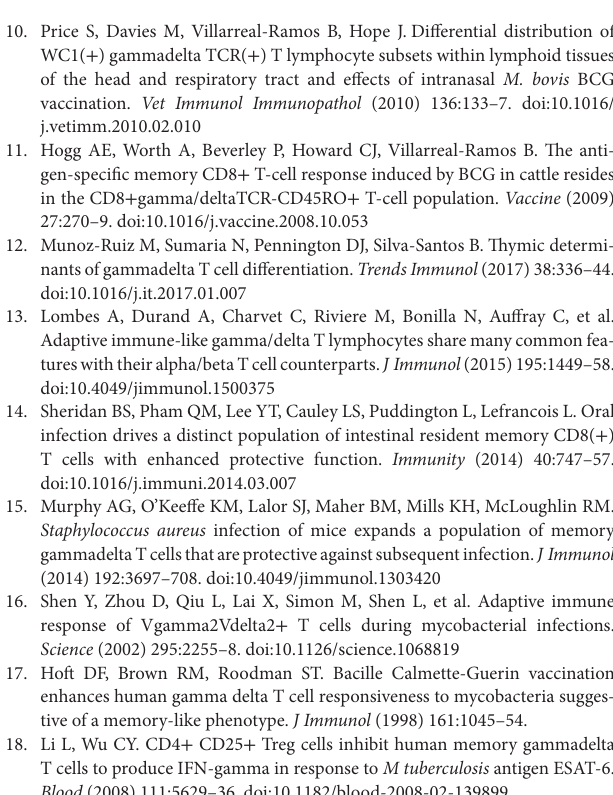
FigUre s1 | Sequence alignment of bovine WC1 genes. General structure of bovine WC1 molecules is shown for 6 and 11 scavenger receptor cysteine rich (SRCR)-containing molecules along with the transmembrane (TM) and